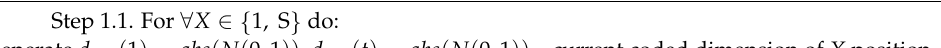
Algorithm 2. The modified MD